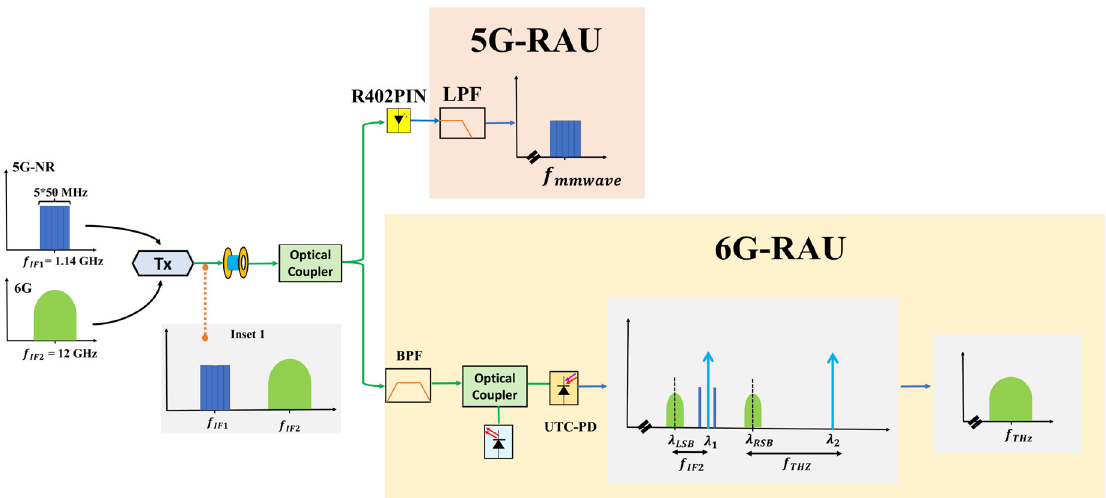
Figure 2. Block diagram explaining the operation principle of RoF-based optical transport system of DAS network capable of supporting 5G and 6G services.